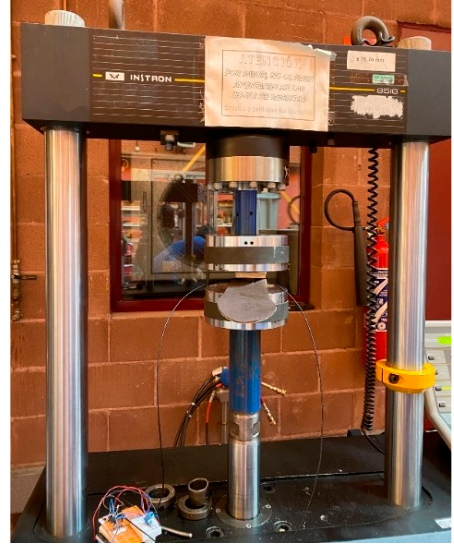
Figure 2. Photograph of the load testing platform with an EVA insole.